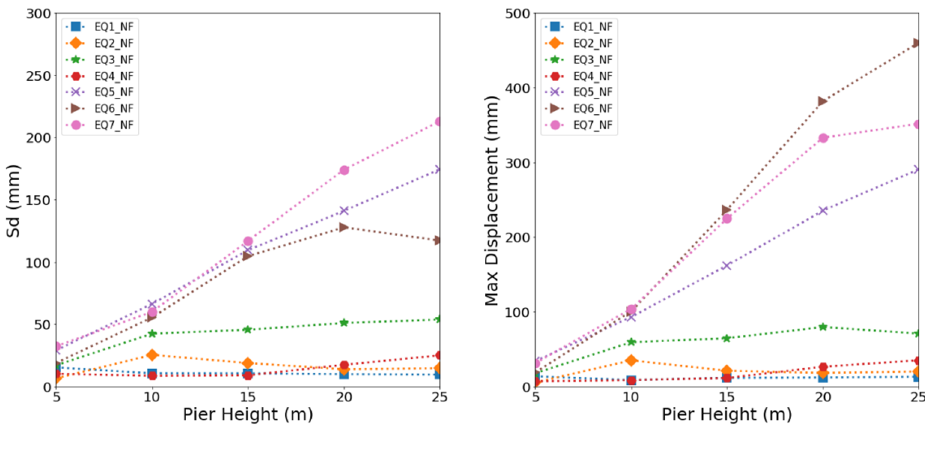
Figure 11. Relationship of the displacement spectrum (S d ) and maximum lateral displacement with the pier height for near-fault ground motions: ( a ) Displacement spectrum at near-fault ground motion; ( b ) maximum displacement at near-fault ground motion.